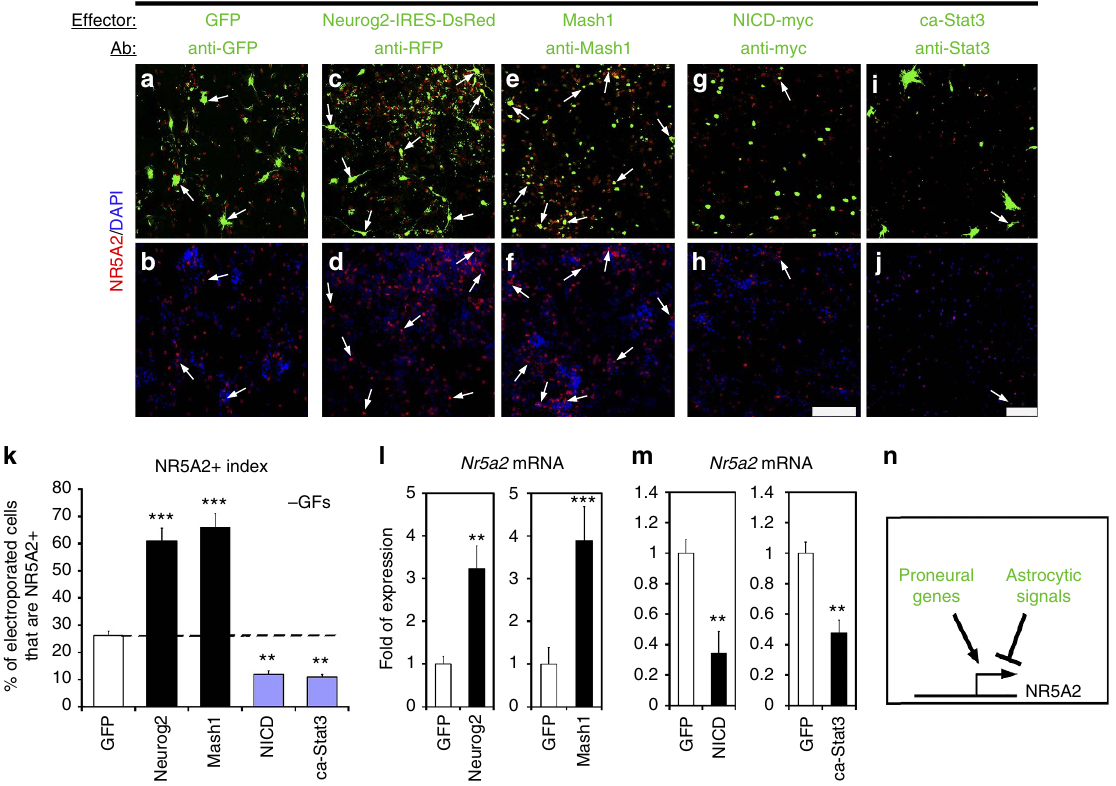
Figure 2 | NR5A2 expression is regulated by proneural and astrogliogenic signals. ( a – j ) Double GFP/NR5A2 ( a , b ), RFP (Neurog2, pseudo-colored green)/NR5A2 ( c , d ), Mash1/NR5A2 ( e , f ), Myc(NICD)/NR5A2 ( g , h ) or Stat3/NR5A2 ( i , j ) immunostainings of NSCs electroporated with various constructs, as indicated. Arrows mark representative cells that co-express the transgenes (green) and NR5A2 protein (red). Cell nuclei were visualized with DAPI staining (blue). ( k ) Quantification of electroporation data shown in a – j (% of transgene þ ; NR5A2 þ /total transgene þ ). ( l , m ) RT–qPCRs showing the quantification of Nr5a2 mRNA levels in differentiating NSCs, electroporated with GFP, Neurog2, Mash1, NICD-myc and ca-Stat3, as indicated. ( n ) Schematic representation of the upstream signals that regulate NR5A2. In every case, arrows indicate representative electroported cells that co-express each marker. The results are shown as mean ± s.d. ** P o 0.01, *** P o 0.001 (Student’s t -test). Scale bars, 100 m